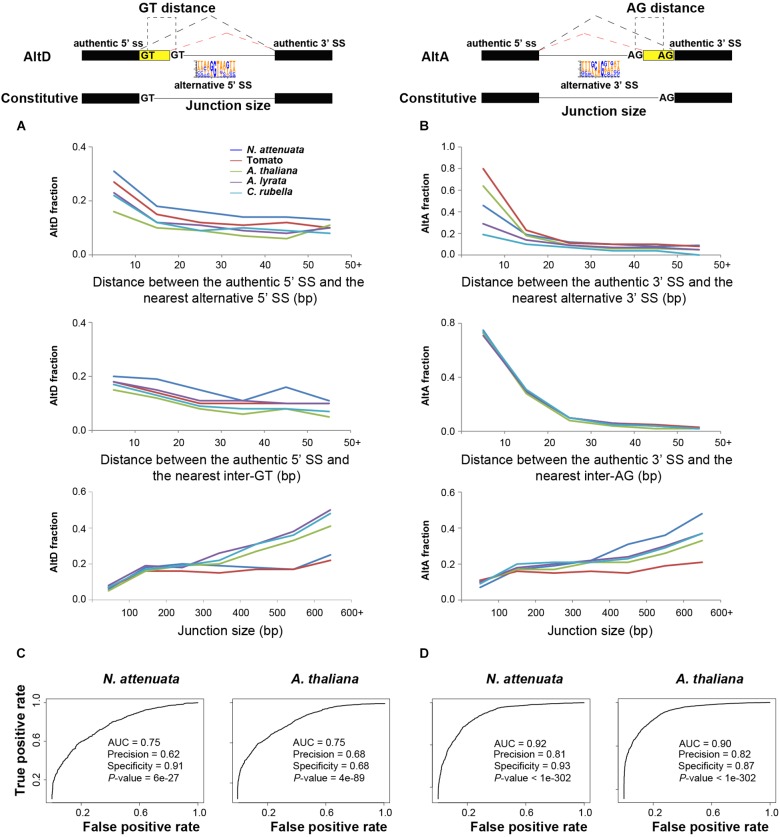
The determinants of alternative 5′ donor site (AltD) and alternative 3′ acceptor site (AltA) in plants. (A,B) The frequencies of AltD/AltA on junctions with different distance between the authentic splice site (SS) and the nearest alternative SS (5′ ss and 3′ ss, respectively), and the distance between authentic SS and the nearest inter GT/AG and junction size. (C,D) The area under the curve (AUC) plot of deep learning models using the key determinants of AltD and AltA in N. attenuata and A. thaliana. The model performance including AUC, accuracy, specificity and significance are also shown.